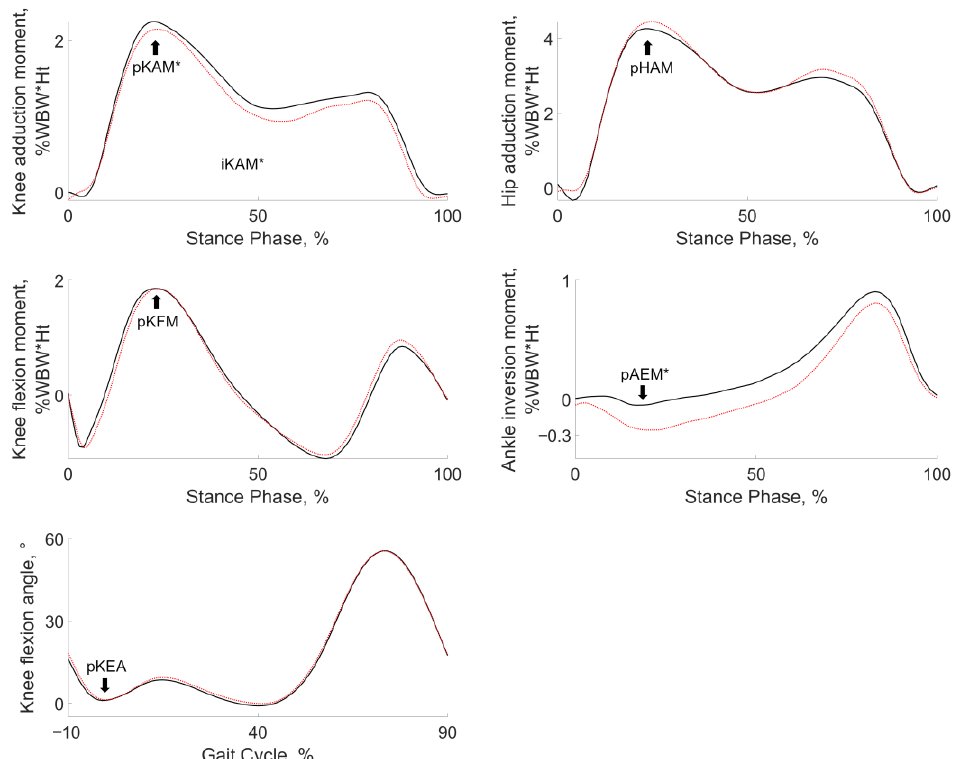
Figure 3. Averaged gait data of all patients walking with an arch support insole (continuous black